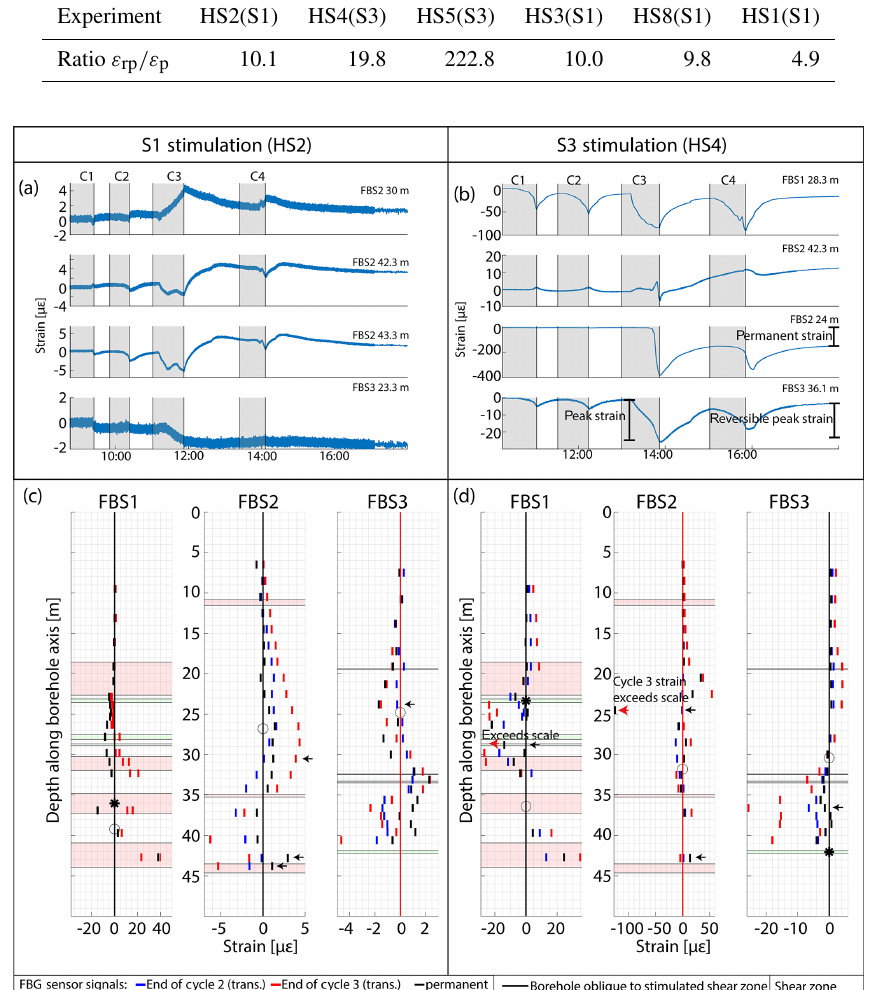
Table 4. Ratio between reversible peak strain magnitude ( ε rp ) and permanent strain magnitude ( ε p ) averaged over all operational gauges and all experiments.